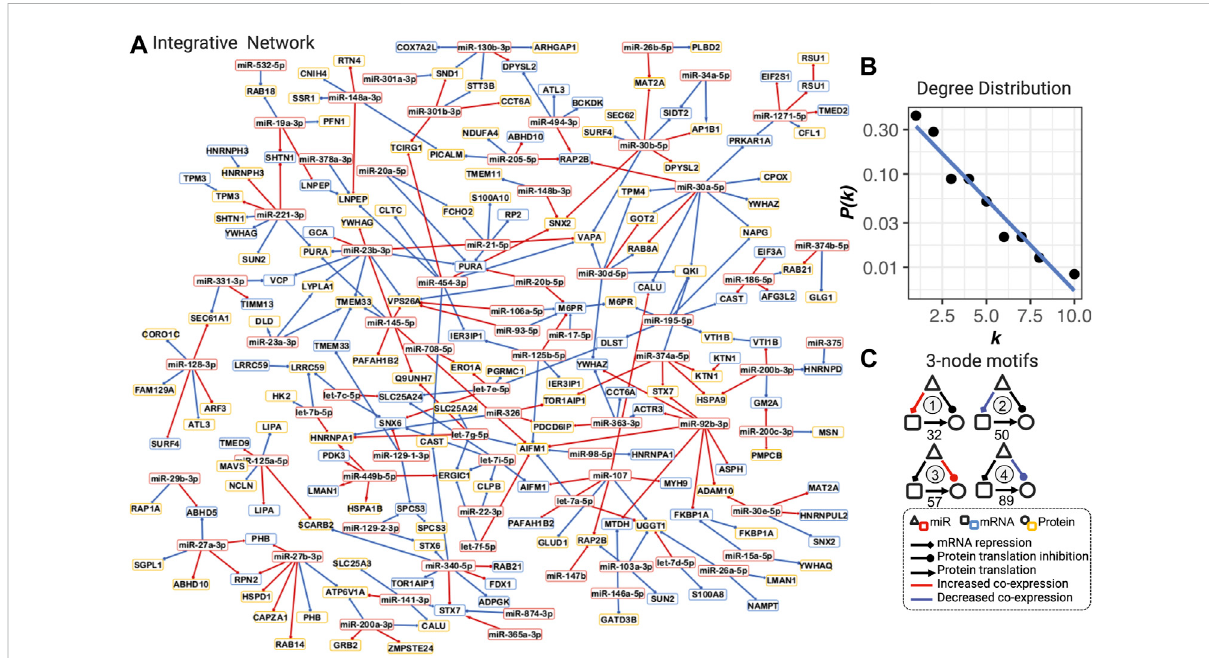
FIGURE 2 Integrative dysregulated network (A) , its degree distribution (B) , and three-node motifs and their counts (C) . (A) Integrative dysregulated network is a directed network from miRNA to mRNA, mRNA to protein, or from miRNA to protein (see legend inset, bottom right). Nodes with red, blue, and yellow borders represent miRNA, mRNA, and protein, respectively. Red and blue edges mean increased or decreased co-expression between COPD and smokers, respectively. The full network with the dynamic layout and searchable gene names and functions in the HTML formatisavailableathttps://chuanxingli.github.io/pages/Sharing/FigS3.htmlandinSupplementaryFigureS3. (B) Power-lawdegreedistributionwith the linear regression of degree (k) ~ the probability of degree (P(k) in log10 scale) of linear regression R-squared = 0.943, p -value = 8.19*10 – 6. (C) Fourmajortypesofthree-nodemotifsandtheircountsintheintegrativenetwork.Motifs1and2meanmiRNAssigni fi cantly(FDR < =0.2)increasedor decreased the regulation of mRNA transcription repression in COPD vs. smoker, respectively. Motifs 3 and 4 mean miRNAs signi fi cantly (FDR ≤ 0.2) increased or decreased the regulation of protein expression (potential protein translation inhibition) in COPD vs. smoker, respectively. The number under the motif is their count in the integrative regulated network. Created using igraph and Cytoscape. The full names of genes are provided in Supplementary Table